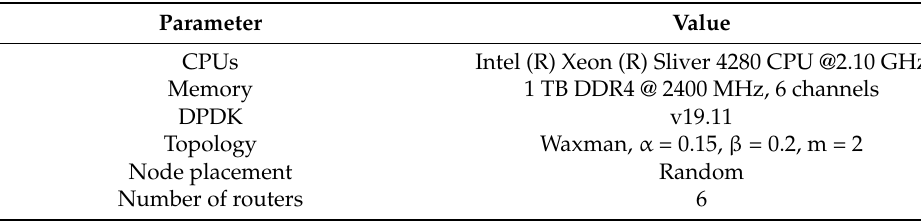
Table 4. Experimental